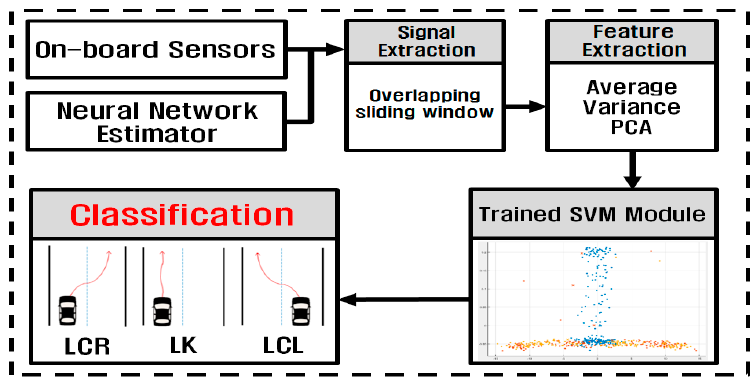
Figure 7. Operation procedure of driver intention recognition using SVM.